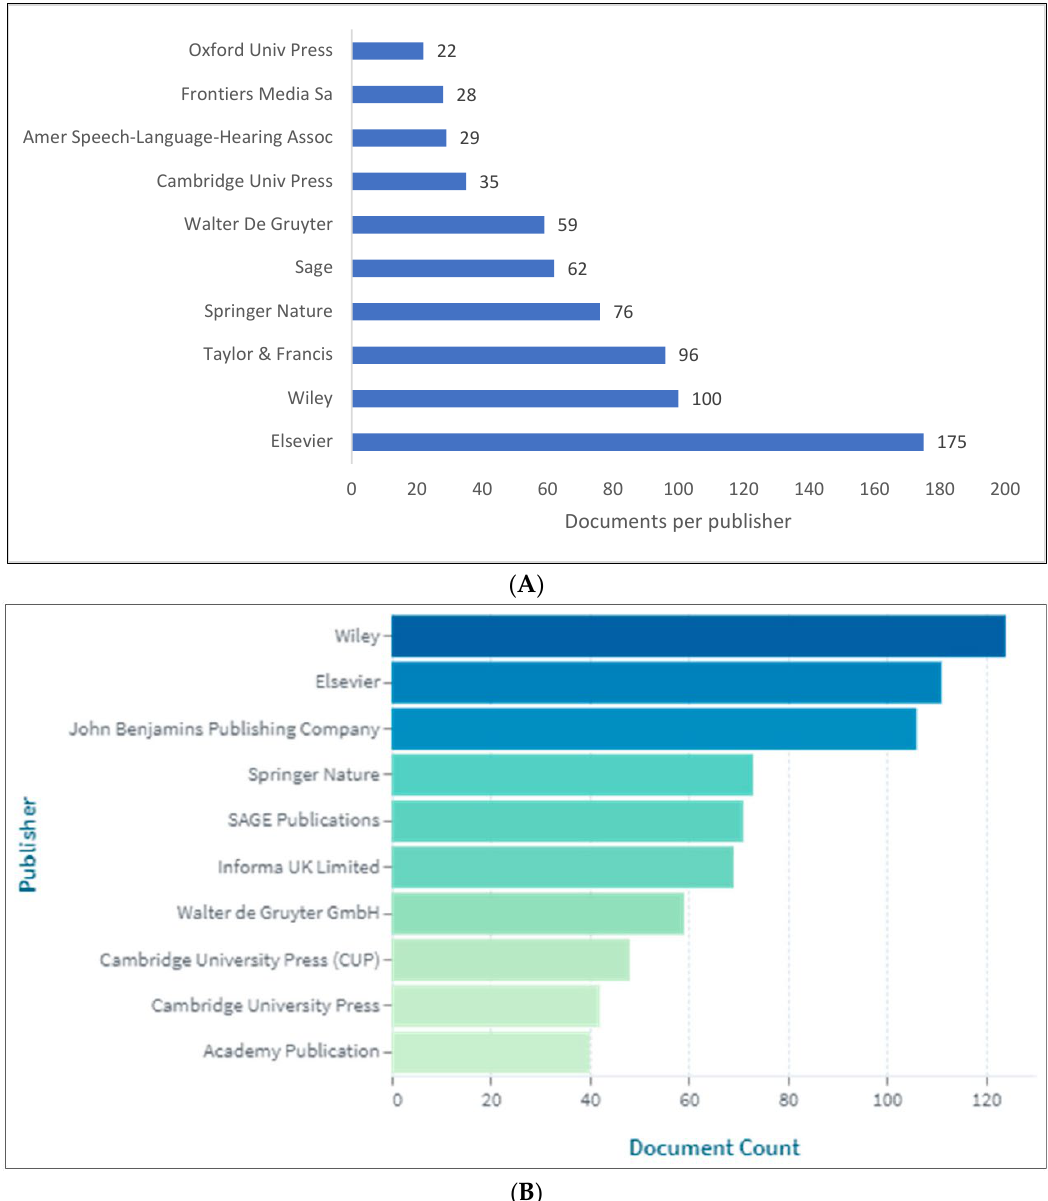
Figure 5. Pragmatic language development knowledge production size by publisher: ( A ) WOS; ( B ) Lens.